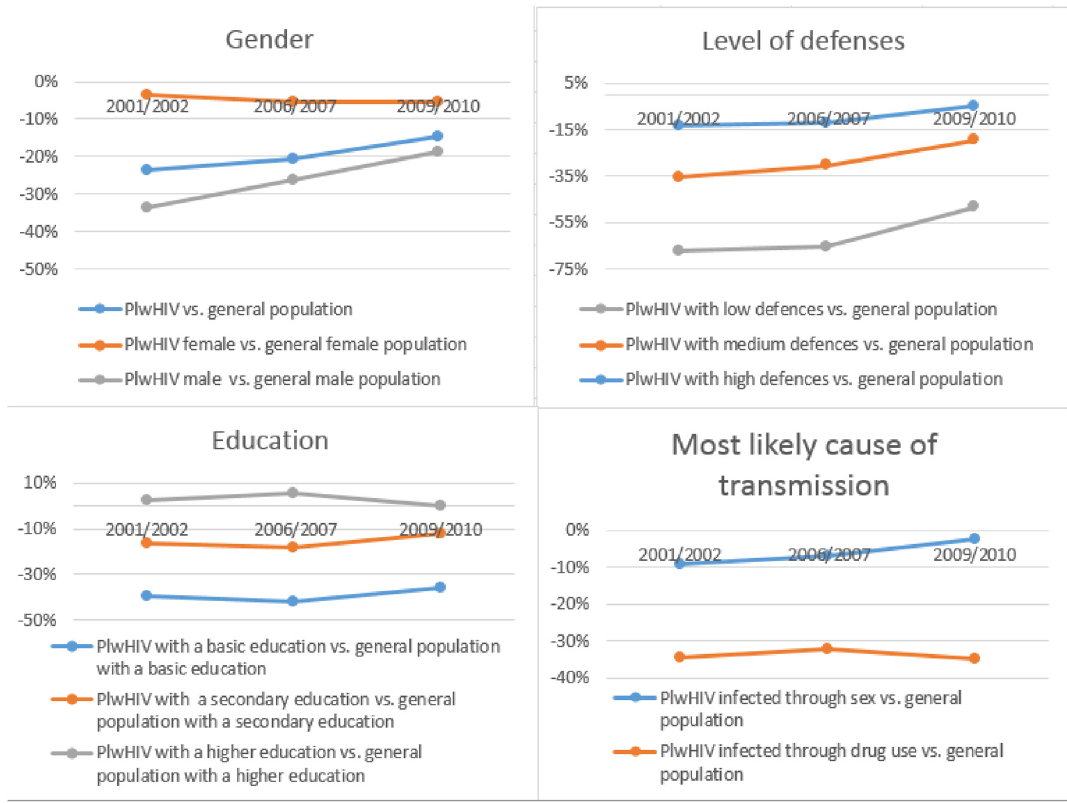
Fig 1. Differences in employment rate between PlwHIV vs general population, by gender, level of defences, education and source of contagious. Results from the matching